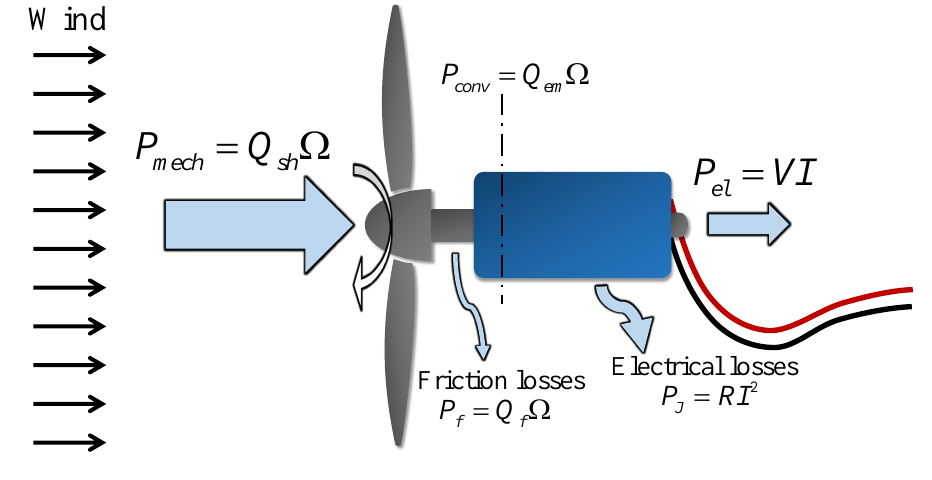
Figure 6. Energy conversion in a miniature wind